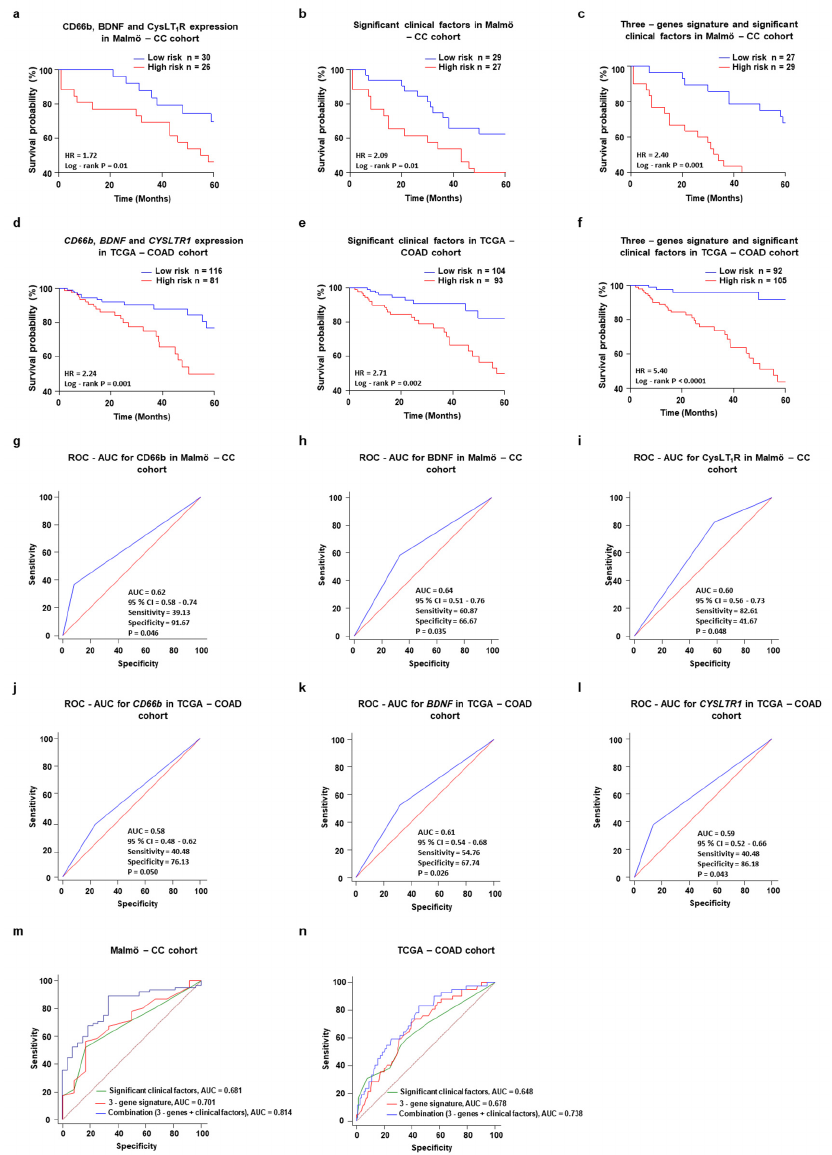
Figure 5. A potential role for BDNF/CysLT 1 R/CD66b as a prognostic predictor of colon cancer development. Prognostic and predictive analysis of CD66b, BDNF and CysLT 1 R protein and gene signatures in patients with colon cancer. ( a ) Kaplan–Meier survival curves according to the three-protein signature (CD66b, BDNF, and CysLT 1 R) expression in subsets of patients with colon cancer. ( b ) Kaplan–Meier survival curves according to significant clinical factors (gender, lymph node metastasis, TNM staging) from univariate analysis in Malmö CC patient cohort ( c ) Multivariate analysis of the three-protein signature with the significant clinical features (gender, lymph node metastasis and TNM staging) in Malmö CC patient cohort, cut-off based on the Youden Index = 0.38, association criteria >3.11. ( d – f ) Kaplan–Meier survival curves according to ( d ) three-gene signature ( CD66b , BDNF and CYSLTR1 ) expression ( e ) significant clinical factors (age, lymph node metastasis and TNM staging) from univariate analysis and ( f ) multivariate analysis of the three-genes signature with the significant clinical features (gender, lymph node metastasis and TNM staging) in TCGA- COAD patient cohort, cut-off based on the Youden Index = 0.39, association criteria >1.91. ( g – l ) ROC curves to determine the predictive ability of ( g ) CD66b, ( h ) BDNF, ( i ) CysLT 1 R expression in Malmö CC patient cohort, and ( j ) CD66b , ( k ) BDNF , ( l ) CYSLTR1 in the TCGA–COAD cohort. ( m , n ) A summary of the ROC curve and prognostic value determination regarding colon cancer clinical features in ( m ) Malmö CC and ( n ) TCGA-COAD patient